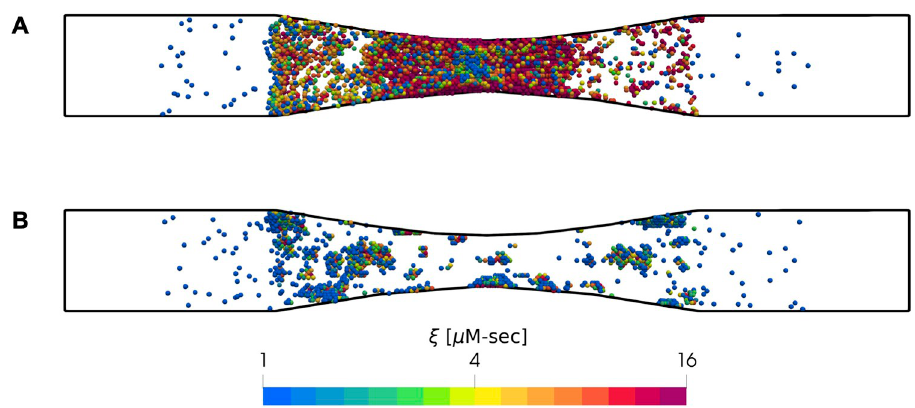
Fig 8. Effect of VWF mediated platelet capture at pathological shear rates. Simulation results of platelet activation (blue indicates inactivated and red, highly activated) in the (A) presence and (B) absence of enhanced clotting function due to VWF stretching at pathological shear rates > 3000s -1 .